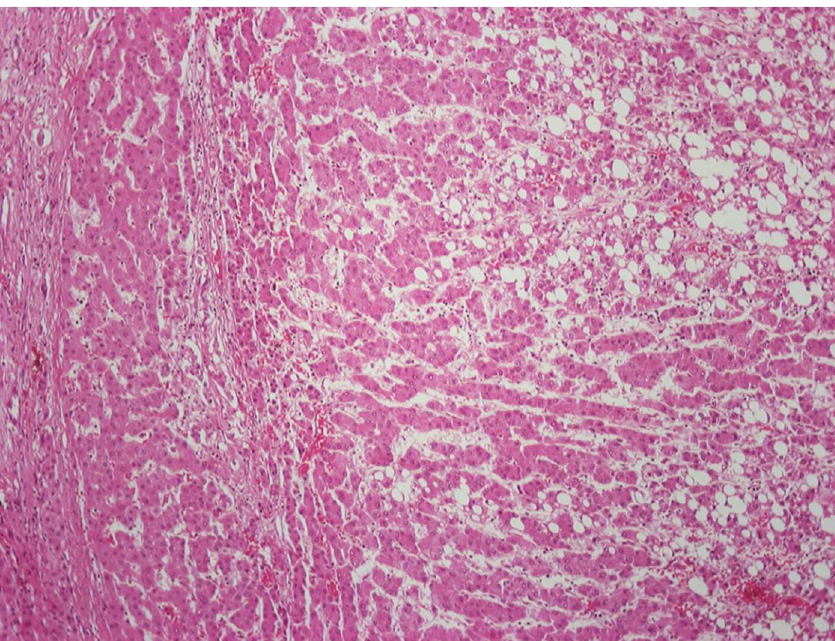
Figure 6. HCC (central and right part of the picture) arising in dysplastic nodule ( left part ). The tumor has features of early HCC ( central part ) and classic HCC with steatosis ( right part ). In resection specimens, histologic distinctions between LGDN and LRN can be coun- terintuitive. LGDNs are more likely to show relatively preserved, even “normal appearing” and function, such as variably regenerative or atrophic hepatocytes, large cell change, and